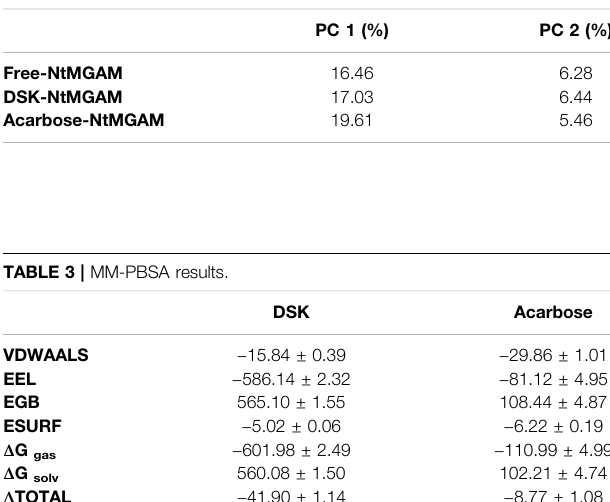
TABLE 2 | The probabilities of PC1 and PC2 of the three systems.